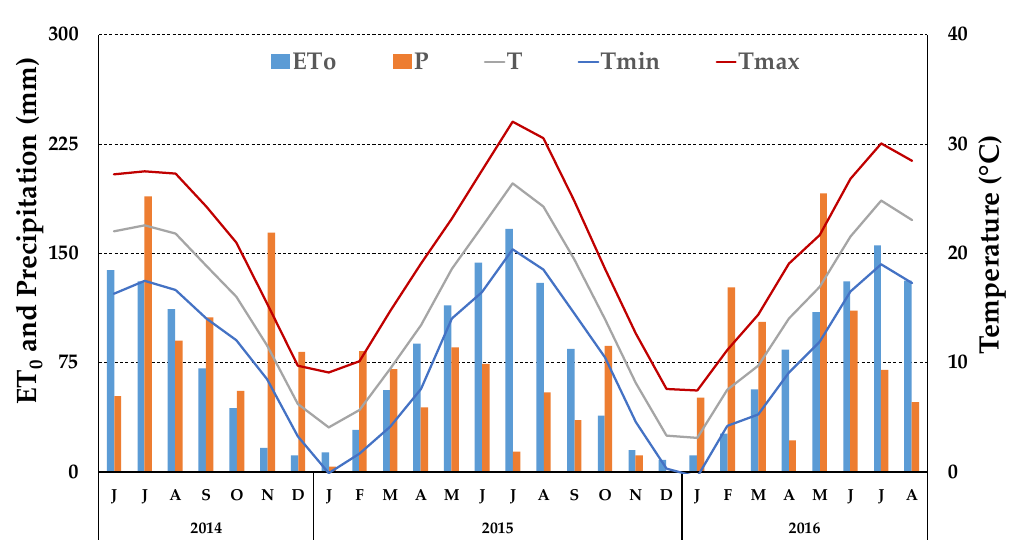
Figure 7. Monthly reference evapotranspiration (ET 0 ), precipitation (P) and average (T), maximum (Tmax), and minimum (Tmin) temperature during the experimental period.